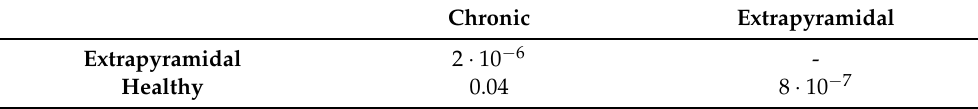
Table 1. p -values of pairwise comparisons using Wilcoxon rank sum test with continuity